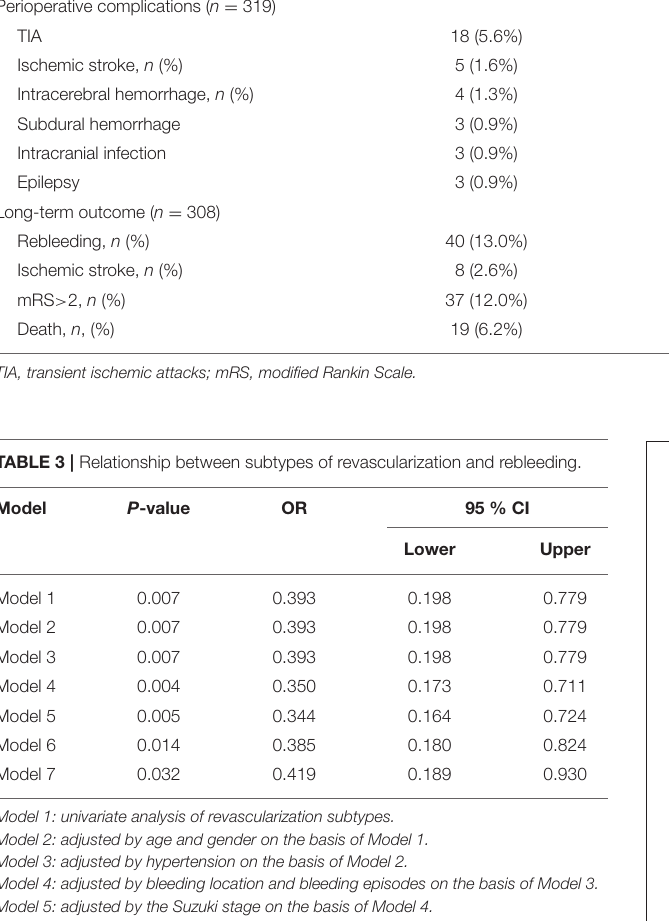
TABLE 2 | The Perioperative complications in 319 operated hemispheres and long-term clinical outcomes in 308 operated hemispheres with available follow-up data. Perioperative complications ( n = 319)